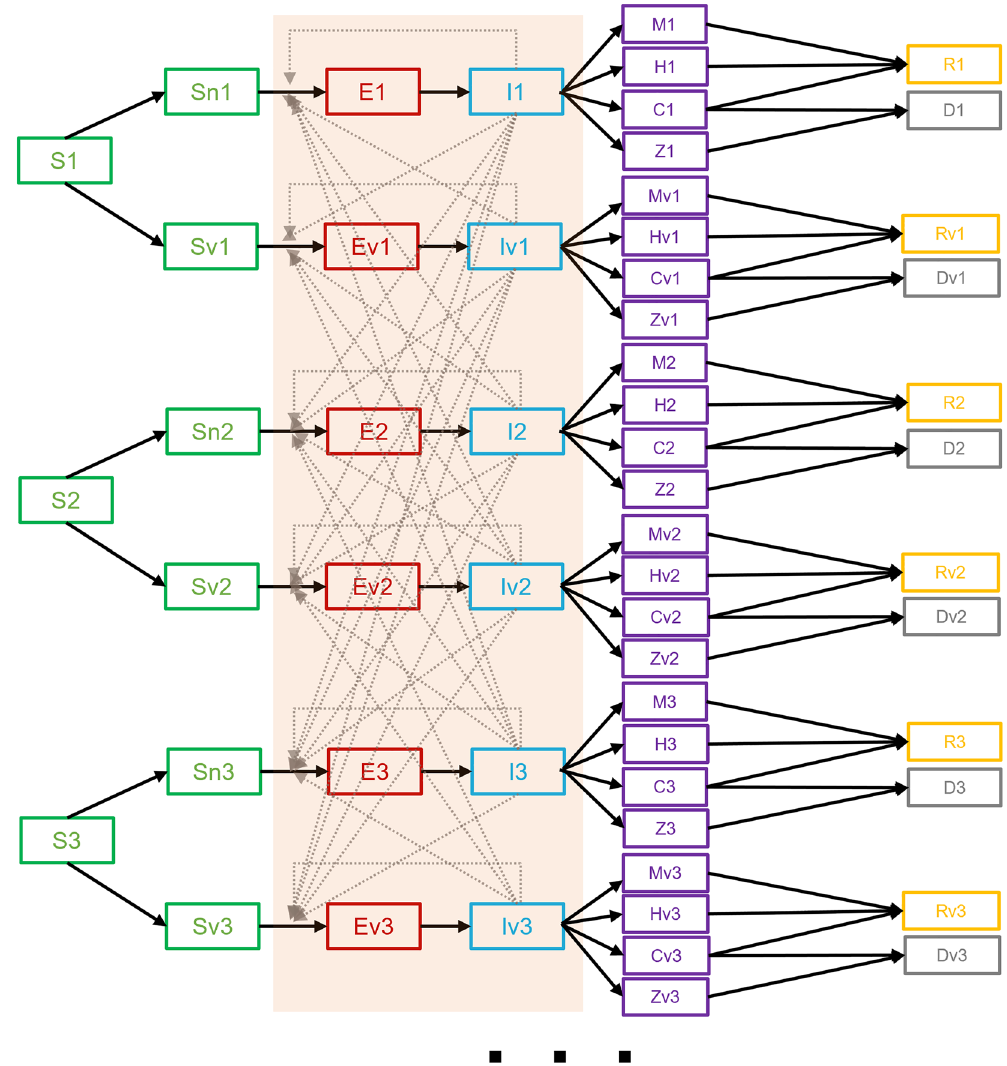
Figure 2. Scheme of the group-stratified extended SEIR model obtained by cloning the base model from Fig. 1, which allows for weighted and time-dependent population mixing between groups. The concept was used to model five population age